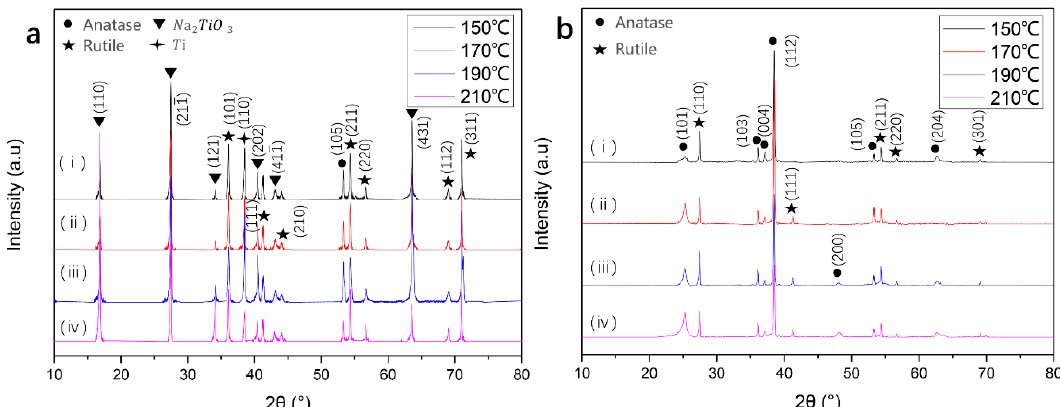
Figure 3. X-ray diffraction (XRD) patterns with different hydrothermal temperatures of micro/nano- Figure 3. X-ray di ff raction (XRD) patterns with di ff erent hydrothermal temperatures of micro / nano- hierarchical structures: (i) Surf 1: 150 °C; (ii) Surf 2: 170 °C; (iii) Surf 3: 190 °C; (iv) Surf 4: 210 °C. ( a ) hierarchical structures: (i) Surf 1: 150 ◦ C; (ii) Surf 2: 170 ◦ C; (iii) Surf 3: 190 ◦ C; (iv) Surf 4: 210 ◦ C. After hydrothermal reaction; ( b ) After annealing treatment at 300 °C for 3 h. ( a ) After hydrothermal reaction; ( b ) After annealing treatment at 300 ◦ C for 3